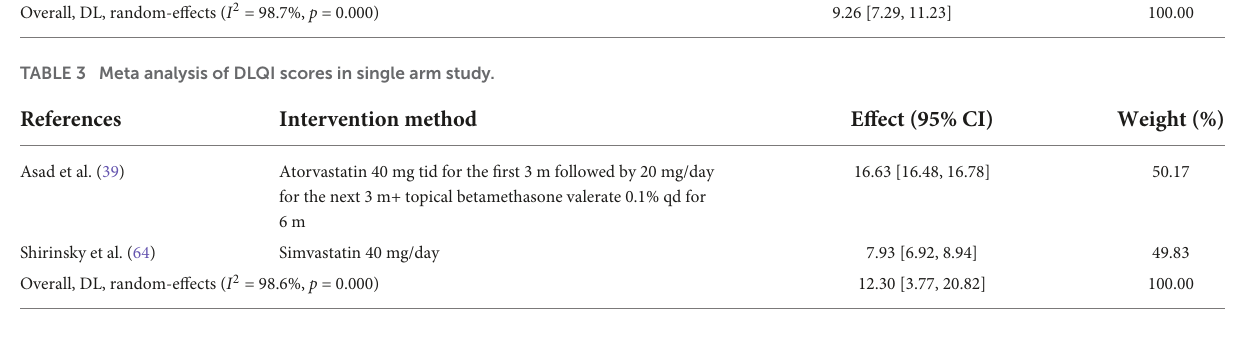
TABLE 4 Meta analysis of LDL-c in single arm